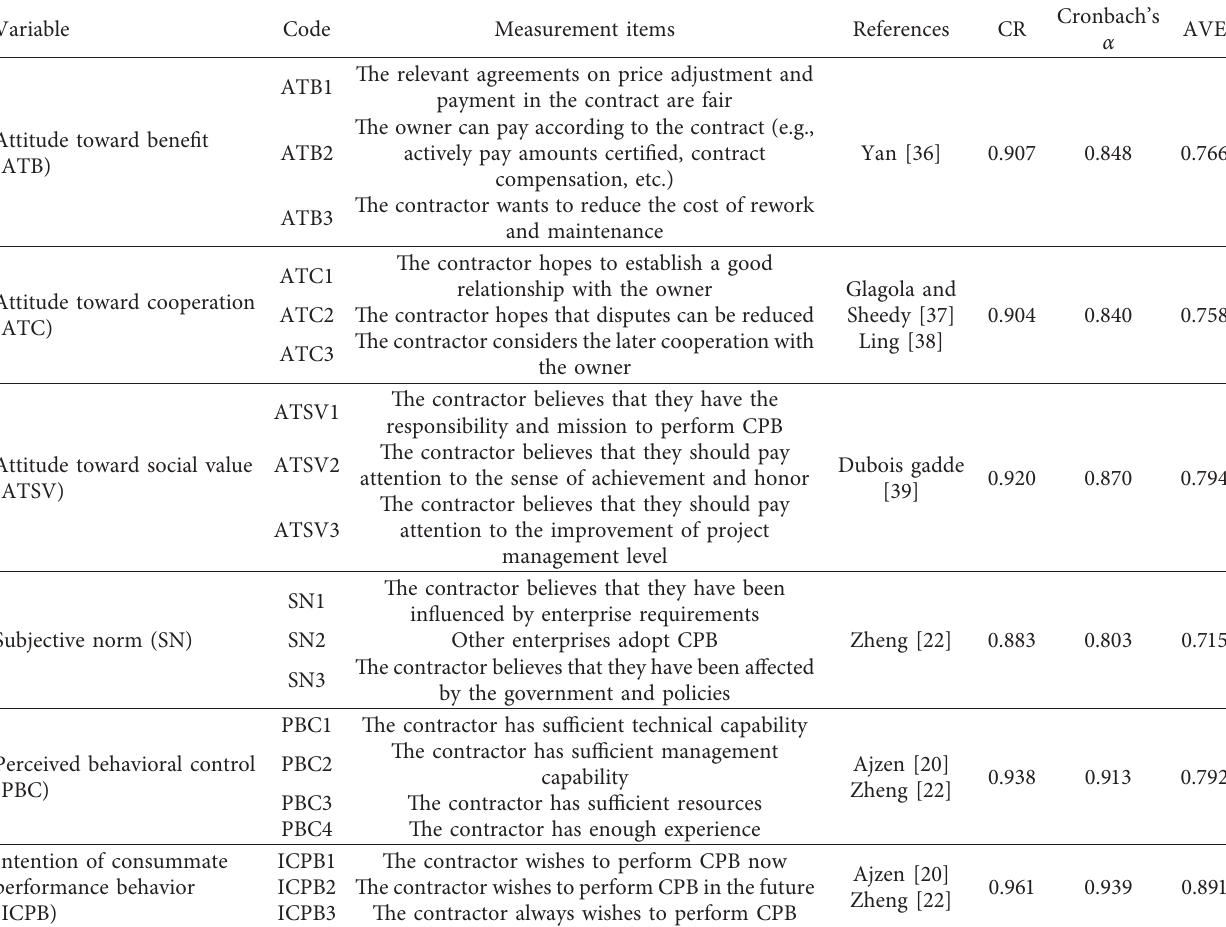
Table 3: Items of measurement and reliability and validity analysis.